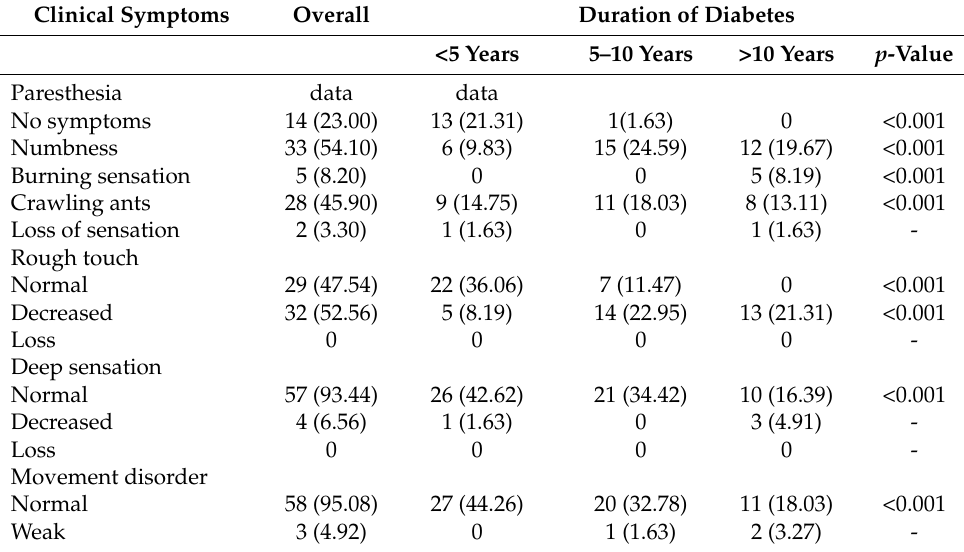
Table 5. The relationship between clinical symptoms and duration of